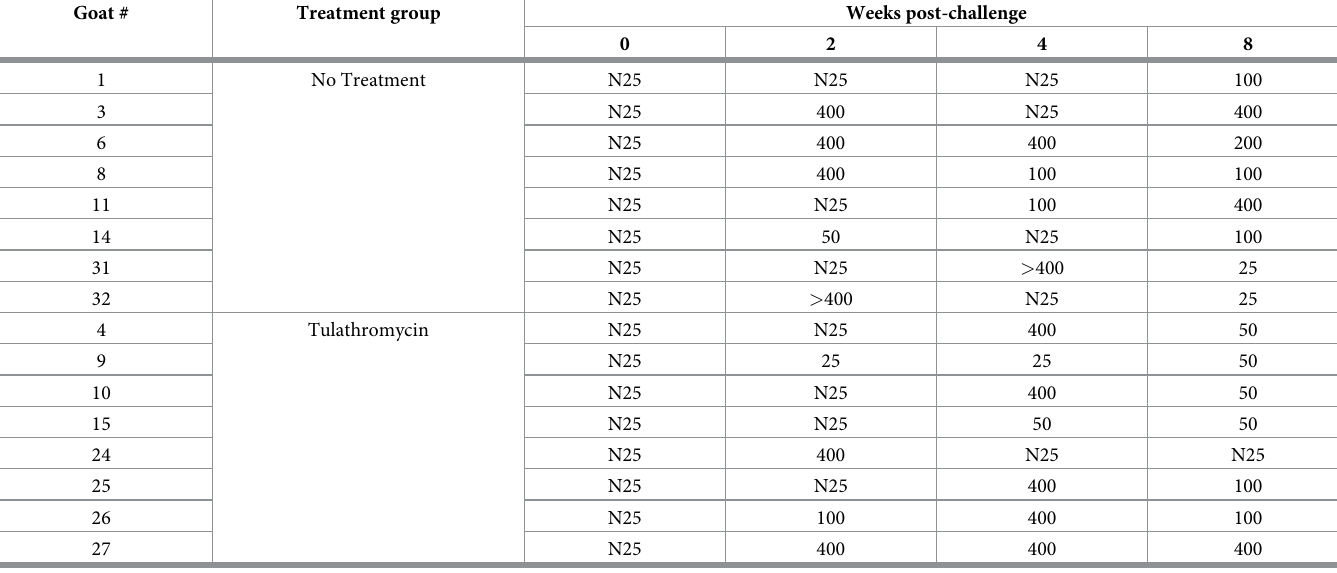
Table 1. Standard agglutination tube data for open animals prior to and post- B . melitensis 16M challenge. Goat #